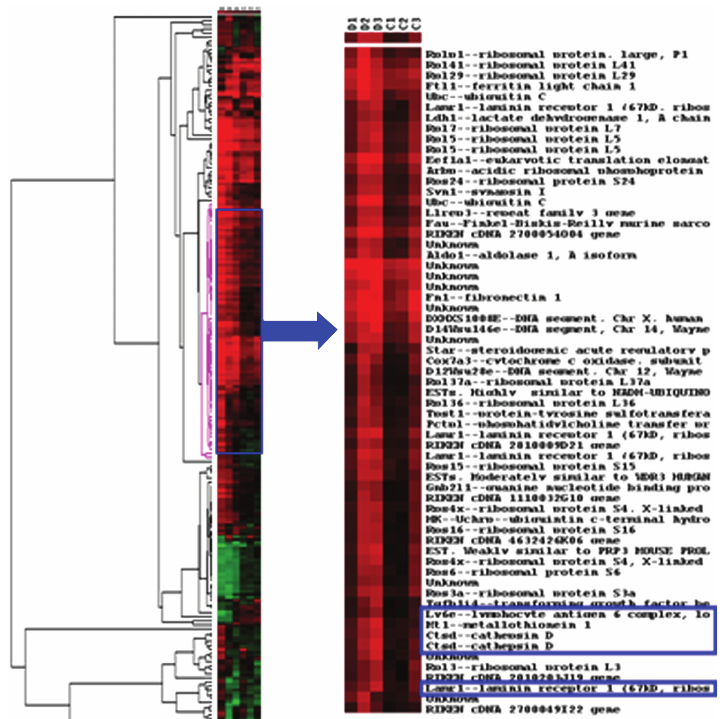
Figure 3: Dendrogram of microarray results from MN kidneys which revealed 175 genes with significantly di ff erent expressions compared with normal kidneys.